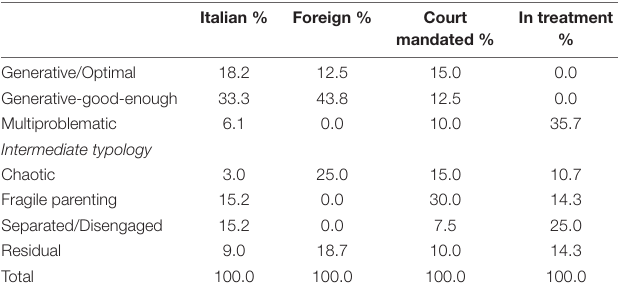
TABLE 8 | Bivariate analysis comparing family characteristics to typological Configurations. Italian % Foreign